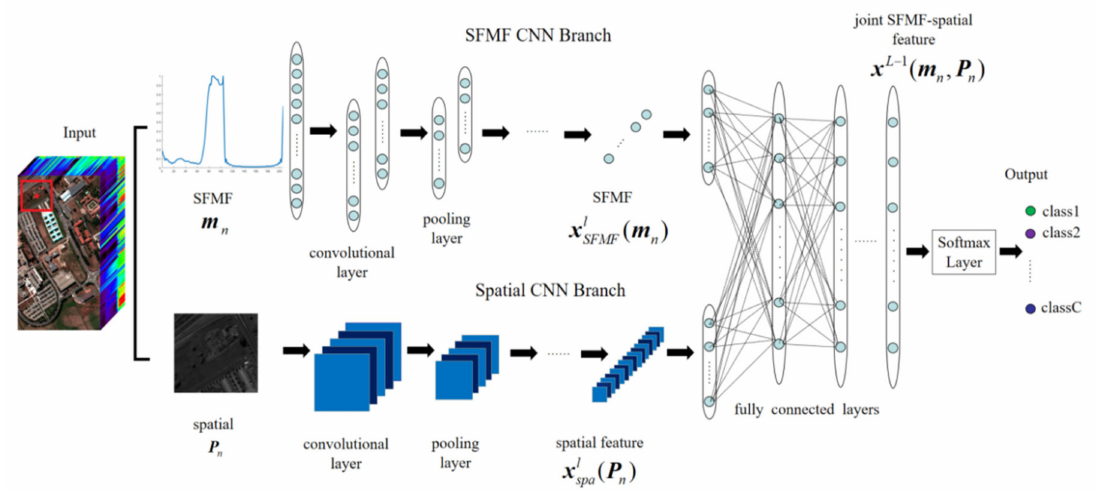
Figure 1. The architecture of proposed two-branch CNN Two-CNN SFMF-spa